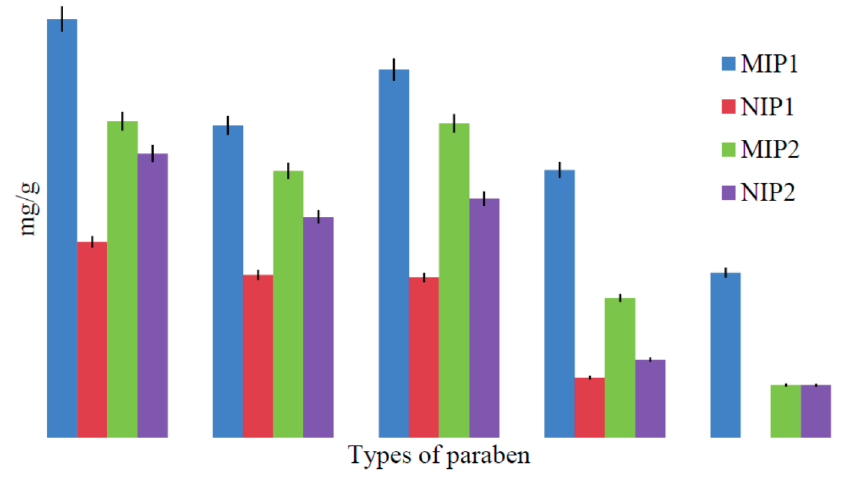
Figure 9. Binding specificity of BzP on MIP1/NIP1 and